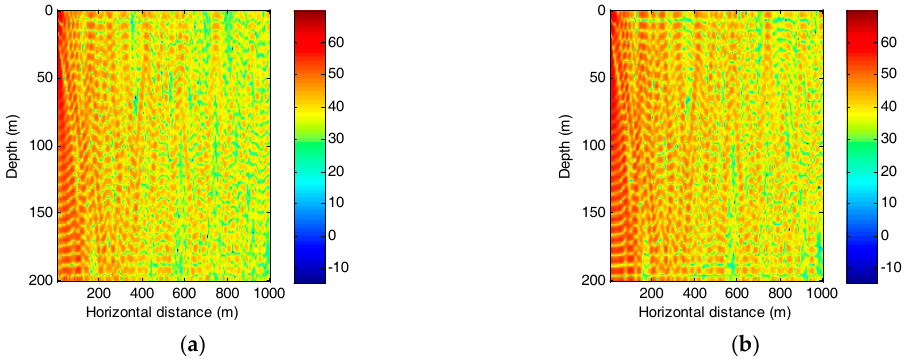
Figure 10. Two-dimensional color figure of SPL using combined WSM and FEM (100 Hz). ( a ) Combined WSM; ( b ) FEM.